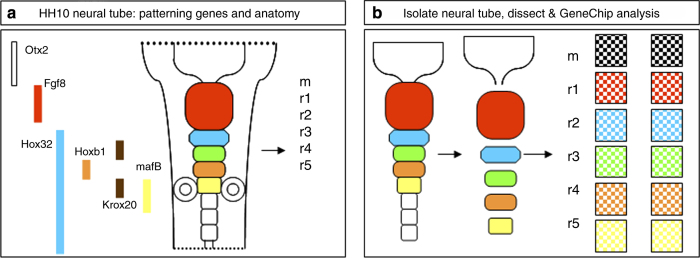
Schematic diagram of neural tube, the key patterning genes and outline of experimental strategy.(a) Schematic diagram of the mid-hindbrain region at chick HH10 and some of the key patterning genes expressed at that time. (b) To assess the suite of genes expressed in each individual rhombomere or the caudal hindbrain, neural tube tissue was isolated from other surrounding tissues, dissected into the appropriate regions and the resulting RNA analysed by profiling on Affymetrix Chicken GeneChip arrays.